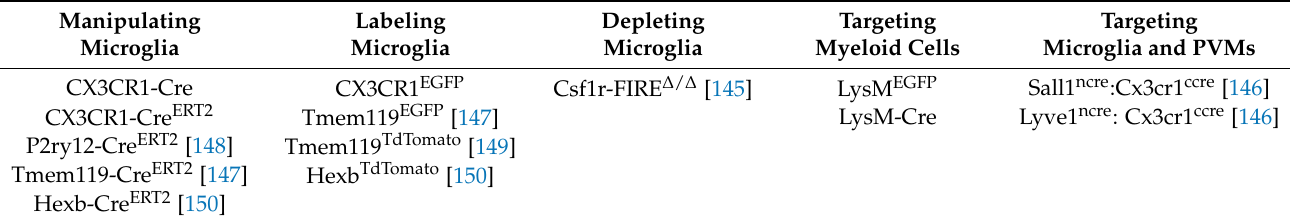
Table 1. Novel in vivo experimental models for studying various subtypes of microglia, myeloid cells, and BAMS. Manipulating Microglia